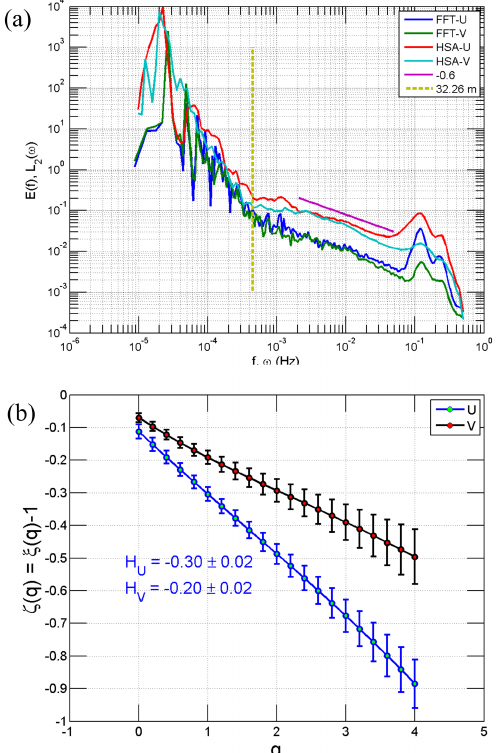
Figure 4. Turbulent power spectra of U and V components of ve- locity fields showing different scaling regimes as calculated by both FFT and HSA (a) . The scaling exponents estimated using the HSA method (b) . The vertical line in (a) shows the memory time of 36.26min found in Eq. (6). Fig. 5c the autocorrelation of S(t) . A memory time of